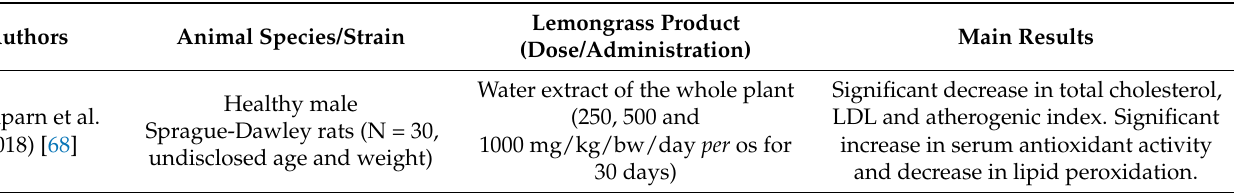
Table 5. Main results of in vivo animal studies describing the cardiovascular activities of